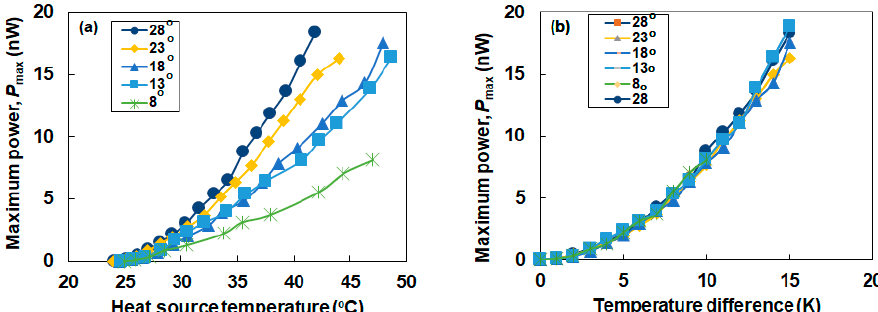
Figure 6. ( a ) Maximum power ( P max ) of thin-film thermoelectric generators as a function of temperature difference ( ∆ T ) and ( b ) P max of the generators as a function of ∆ T